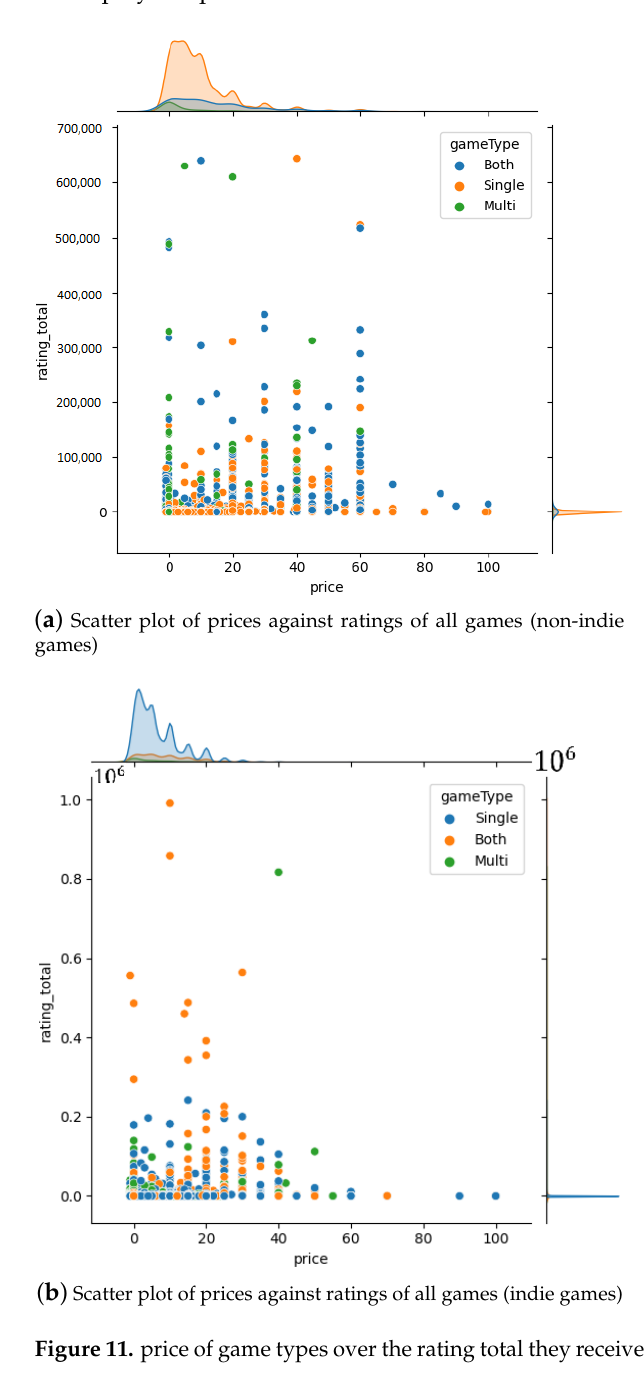
Figure 11. price of game types over the rating total they received for ( a ) non-indie games and ( b ) indie